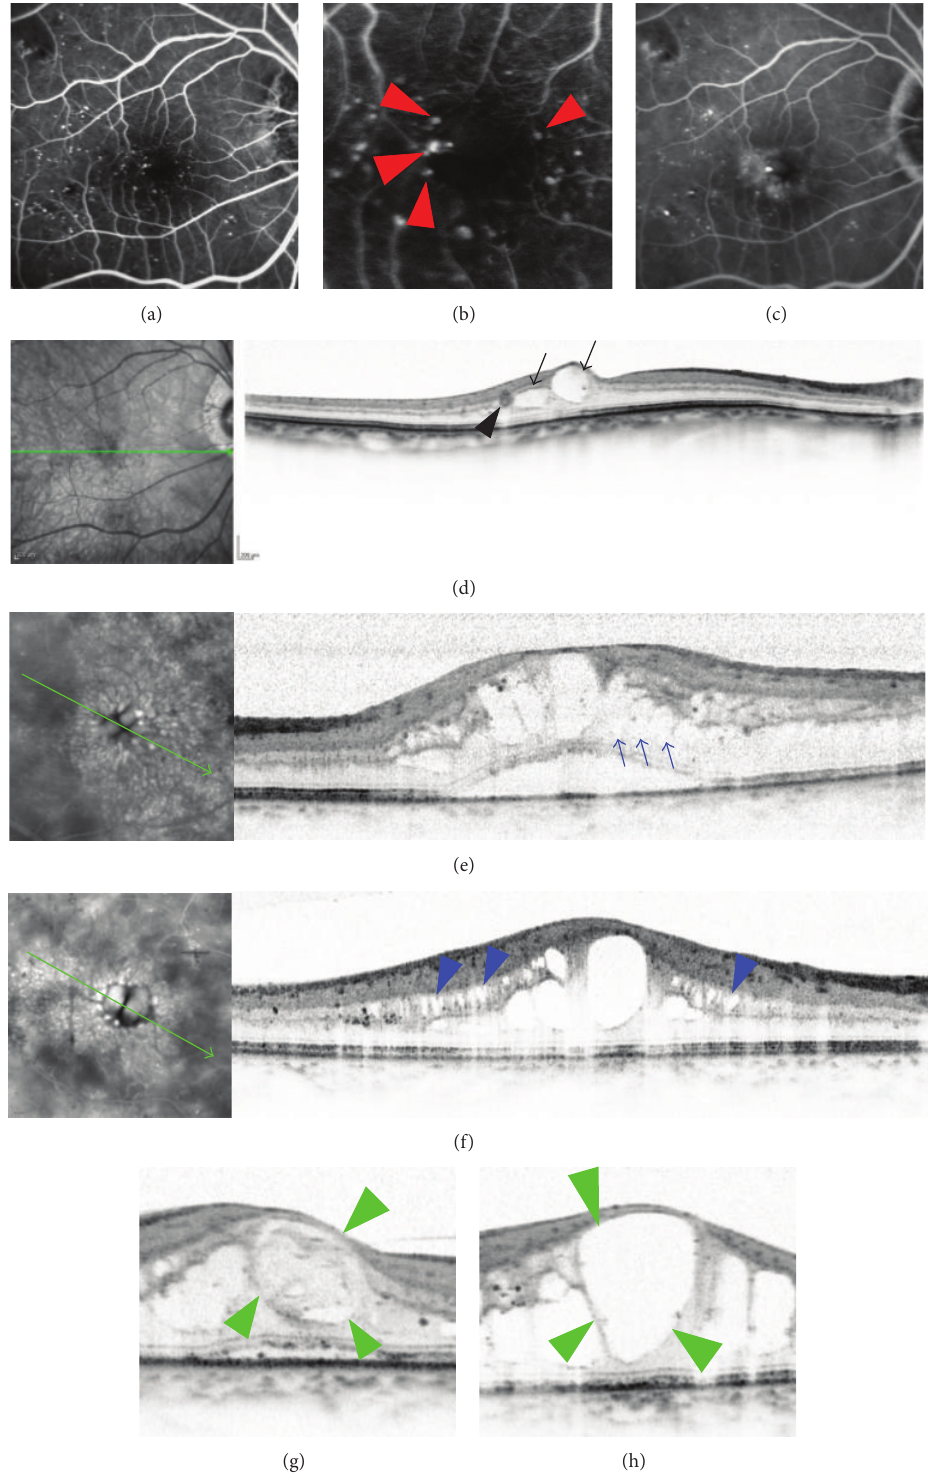
Figure 3: Characteristics of cystoid spaces in DME. ((a), (b)) Early-phase FA shows an enlarged foveal avascular zone and surrounding microaneurysms (arrowheads). (c) A late-phase image shows fluorescein pooling at the fovea. (d) Cystoid spaces (arrows) are accompanied by microaneurysms (arrowhead). (e) A late-phase FA image shows petalloid- (e) or honeycomb-pattern (f) fluorescein pooling, which is considered to correspond to cystoid spaces in OPL (arrow) or INL (arrowhead), respectively, on OCT image. Foveal cystoid spaces (arrowheads) have higher OCT reflectivity and its heterogeneity (g) or lower and homogeneous reflectivity